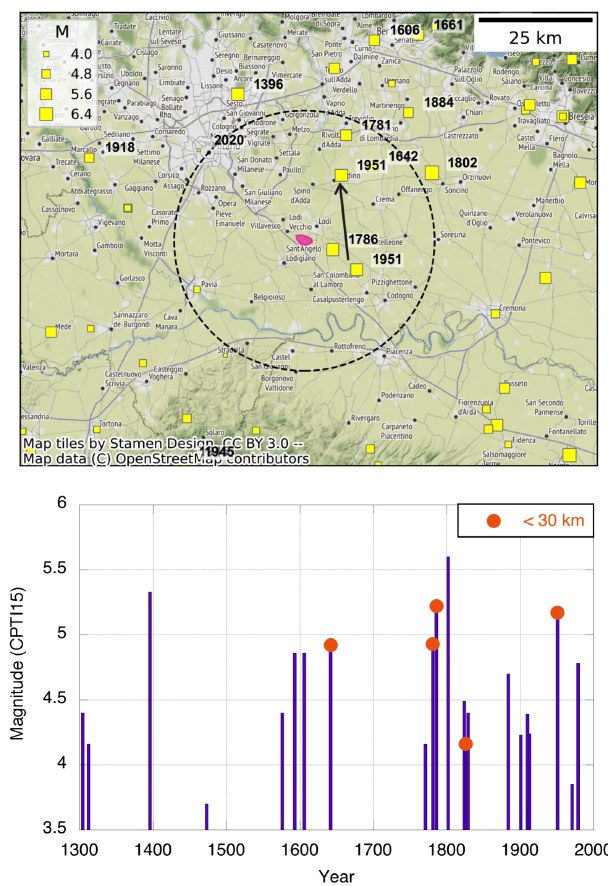
Figure 3. Seismicity of the Lodi area according to CPTI15, v. 3.0 (Rovida et al., 2021); top panel: epicentral map (© OpenStreetMap contributors, 2021. Distributed under the Open Data Commons Open Database License (ODbL) v1.0) – the black arrow shows the shift between the macroseismic (lower) and one of the instrumental (upper) epicentres for the 1951 main event as relocated by Caciagli et al. (2015); bottom panel: plot of magnitude versus time for events located within 50km distance of the